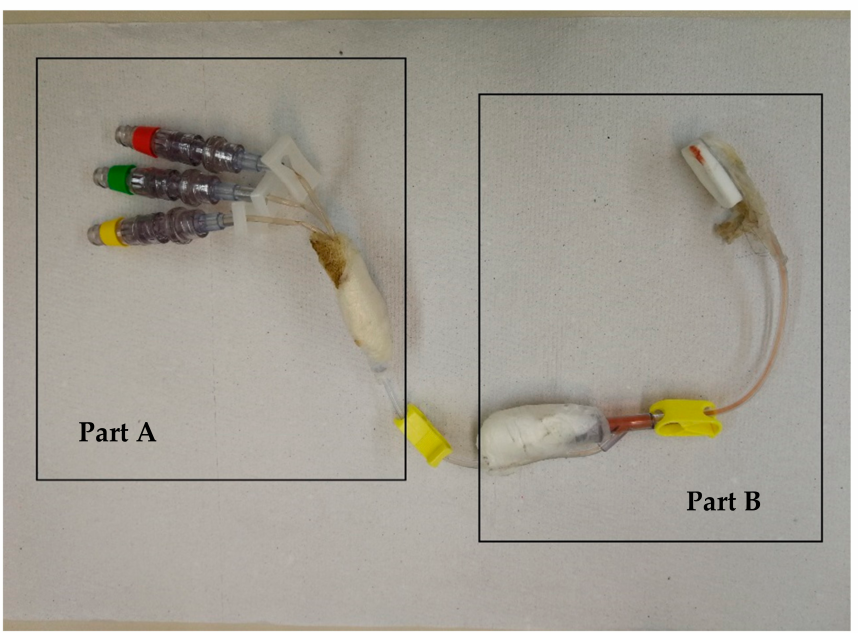
Figure 1. Central venous catheter recovered in deceased’ under-right clavicular